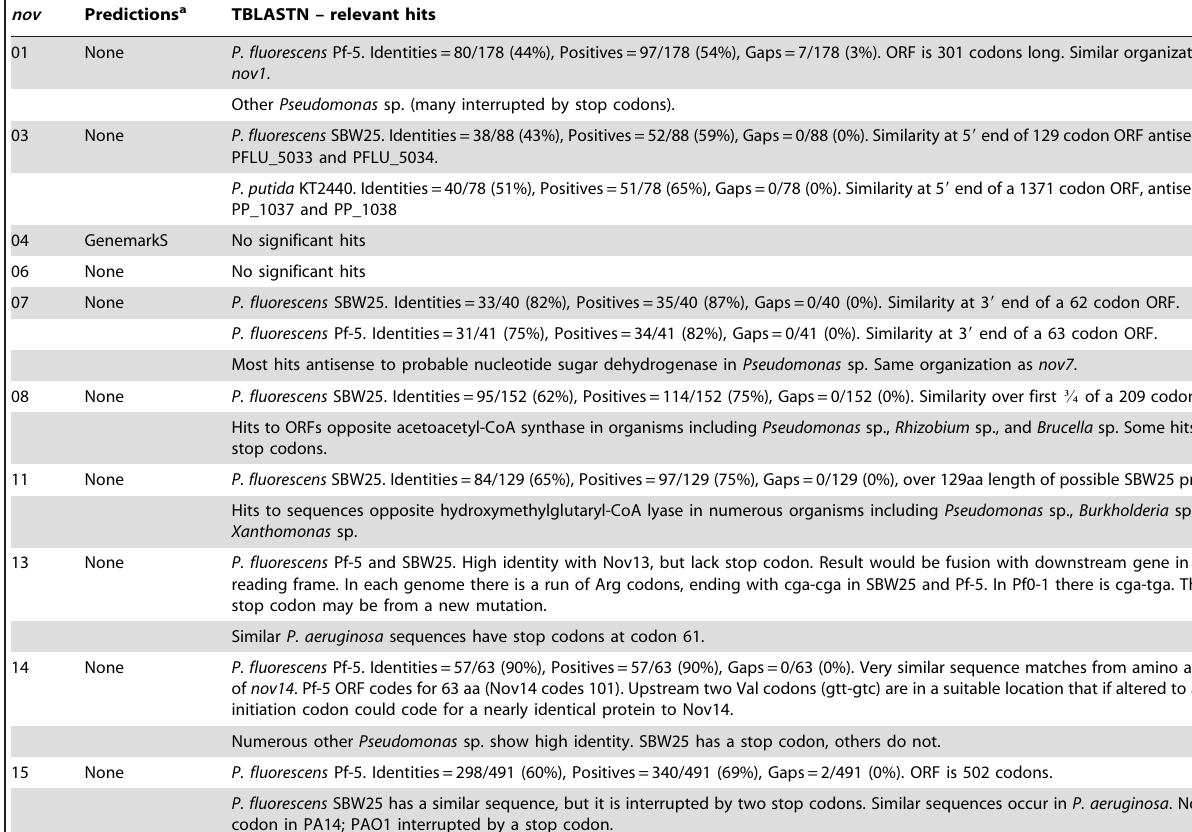
Table 2. Analysis of nov genes that overlap predicted genes in P. fluorescens Pf0-1.